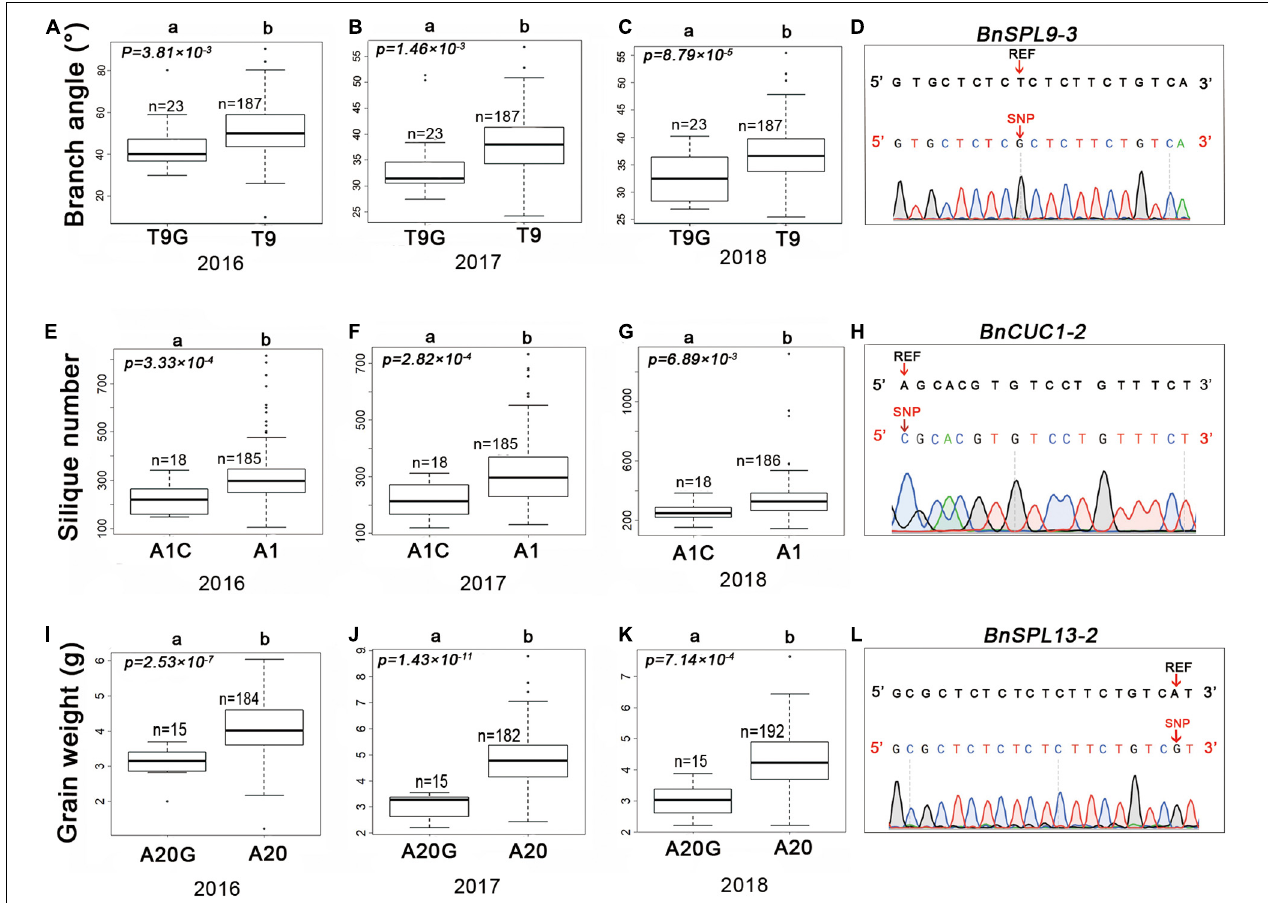
FIGURE 4 | Haplotypes of candidate SNPs for the branch angle, silique number, and seed weight in rapeseed. Boxplots of the branch angle, silique number, and seed weight according to the SNP genotyping of BnSPL9-3 (A–C) , BnCUC1-2 (E–G) , and BnSPL13-2 (I–K) . (D,H,L) Validation of variants in the candidate genes by Sanger sequencing. The variants are indicated by a red arrow. REF represents the reference sequence. Differences between the genotypes were analyzed using the Wilcoxon rank-sum test R package; “n” represents the number of accessions, whereas “a” and “b” represent significant differences at the 5% level.